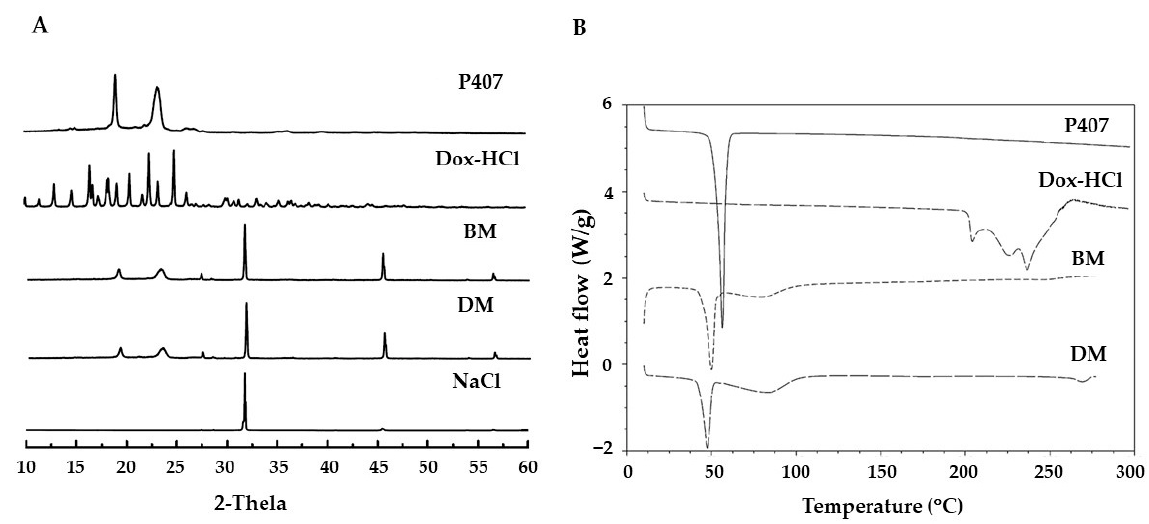
Figure 2. ( A ) Crystalline characteristics and ( B ) thermal behavior of Dox in Dox-micelle (DM) com- pared with blank-micelle (BM), Dox-HCl, and